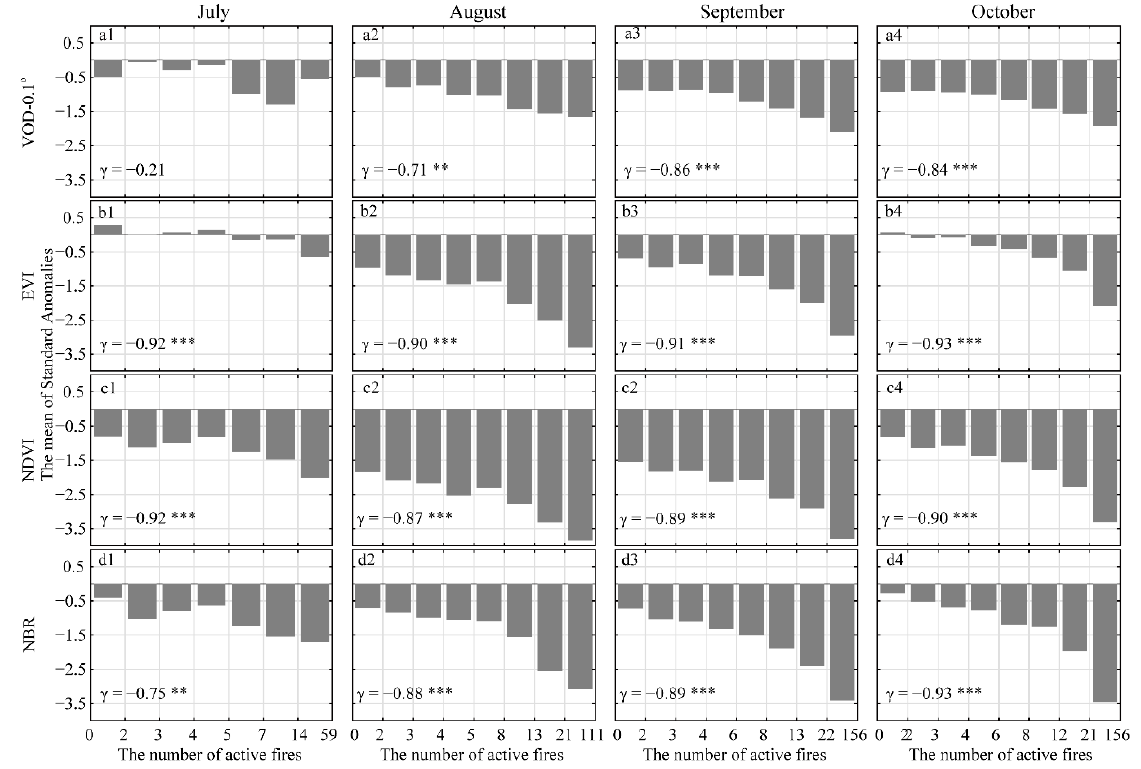
Figure 6. The mean of standard anomalies of ( a1 – a4 ) VOD-0.1°; ( b1 – b4 ) EVI; ( c1 – c4 ) NDVI; and ( d1 – d4 ) NBR at different fire event levels from July to October. The significant Pearson correlation coefficient ( p < 0.1, p < 0.05, and p < 0.01) was indicated with *, **, and ***, respectively.